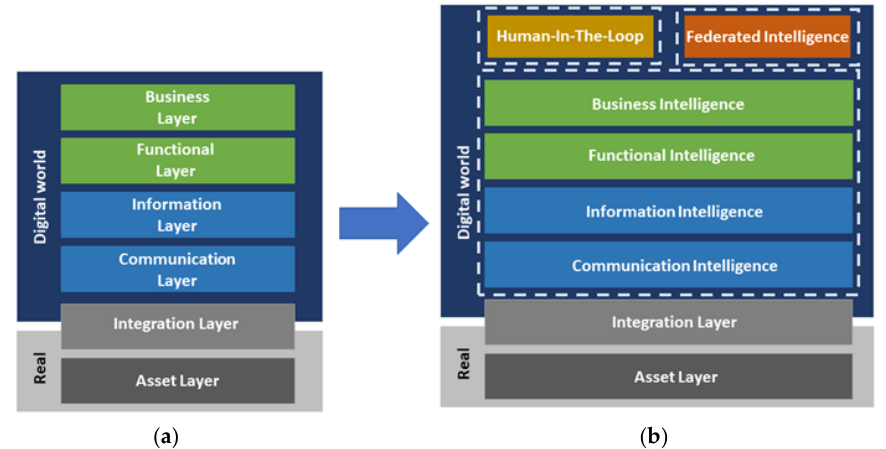
Figure 1. Reference Architectural Model for Industry (RAMI) 4.0 architecture ( a ) and proposed extensions ( b ).